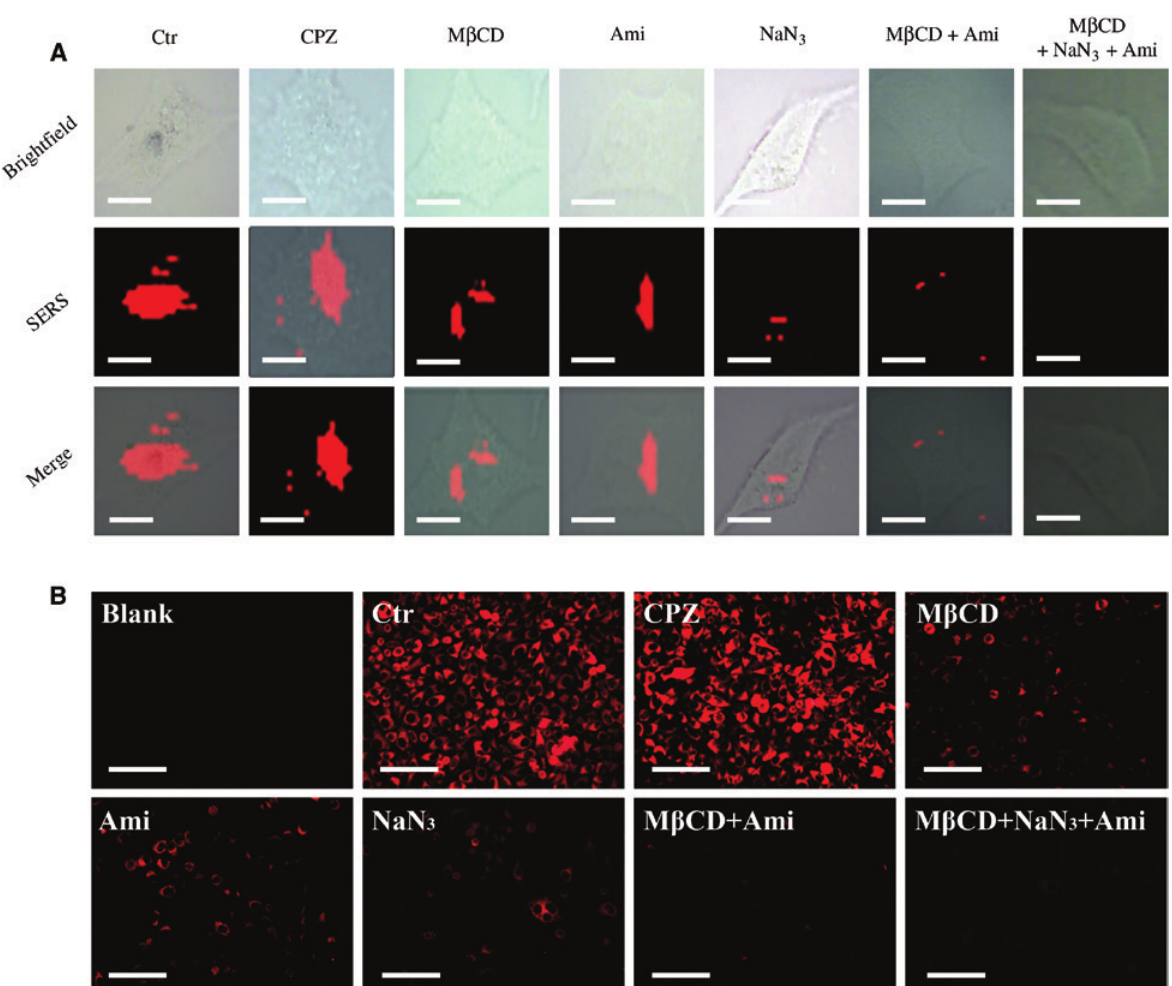
Figure 4: (A) Raman mapping of HepG2 cells incubated with BP-Au NSs after treatment with different endocytic inhibitors (scale bar: 10 μ m). (B) Fluorescence images HepG2 cells incubated with BP-Au/Rh B in the presence of various endocytosis inhibitors. Scale bar: 200 μ m.